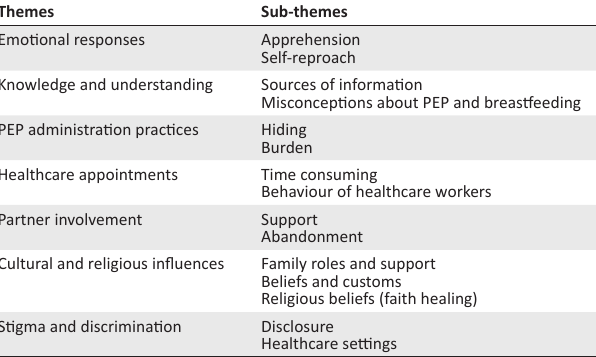
TABLE 2: Themes and